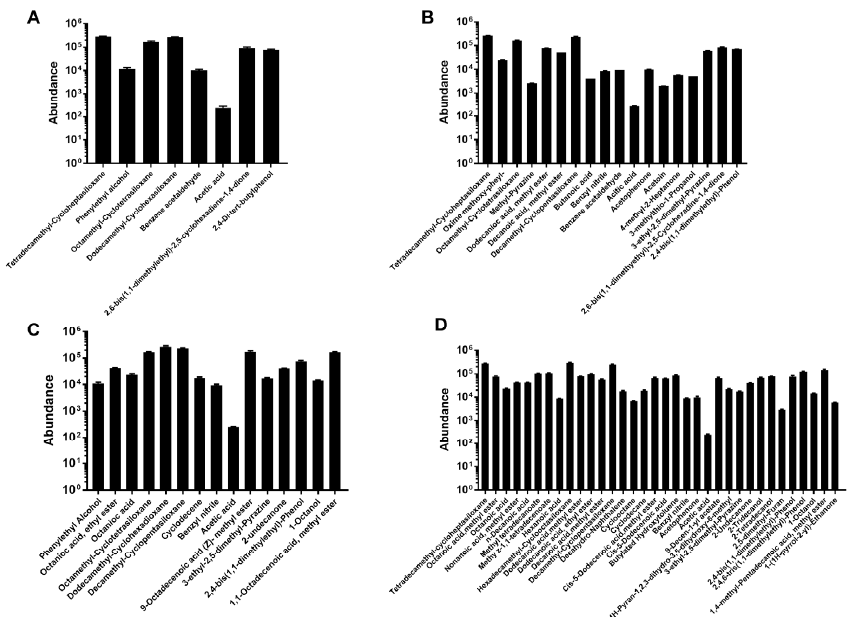
Figure 4. The profile of volatile organic compounds (VOCs). ( A , B ) The profile of VOCs of L. paracasei 85 without or with ZEN treatment. ( C , D ) The profile of VOCs of L. buchneri 93 without or with ZEN treatment.